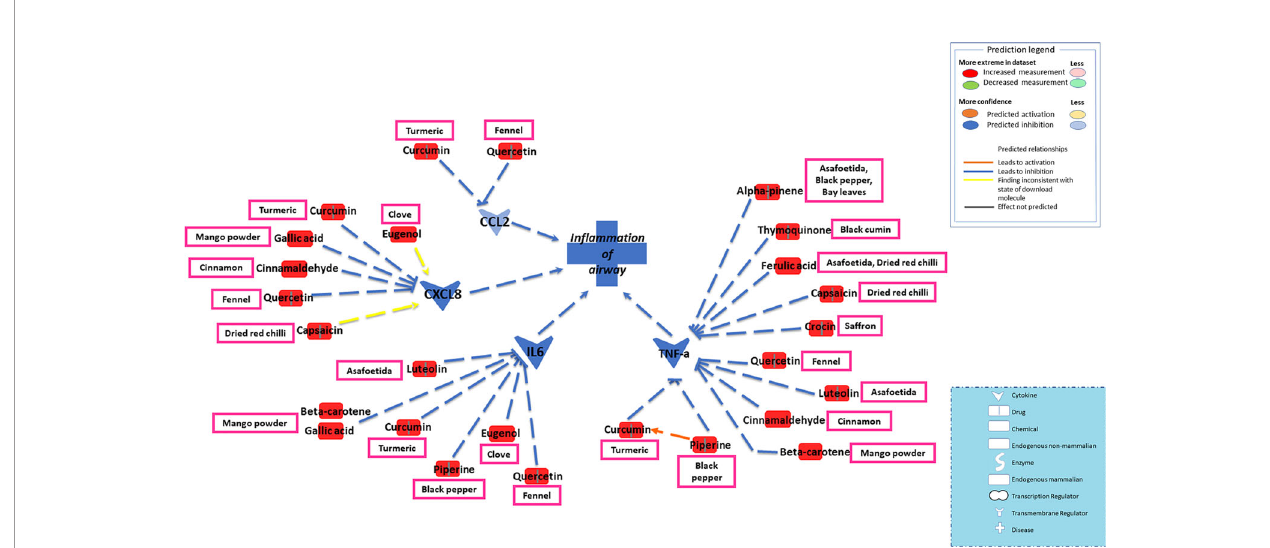
FIGURE 3 | Network depicting direct or indirect interactions between bioactive components in spices and key in fl ammatory mediators such as TNF- a , CXCL8 (IL8), IL6, and CCL2 known to be elevated in COVID-19 patients. Hypercytokinemia in COVID-19 patients is associated with elevated levels of in fl ammatory cytokines, including tumor necrosis factor-alpha (TNF- a ), interleukins (IL6, IL8), and chemokine CCL2. Levels of these pro-in fl ammatory cytokines get further increased in hospitalized COVID- 19 patients. Based on the IPA data, a focused view on the interaction among these cytokines and bioactive components is depicted. The bioactive components can predictably inhibit TNF- a , CCL2, CXCL8 (IL8), and IL6. Further, the IPA network demonstrates the synergistic effects between most of the bioactive components and multiple in fl ammatory mediators. Piperine and curcumin cross-talk that enhance their downstream effects in TNF- a inhibition depicted in the IPA